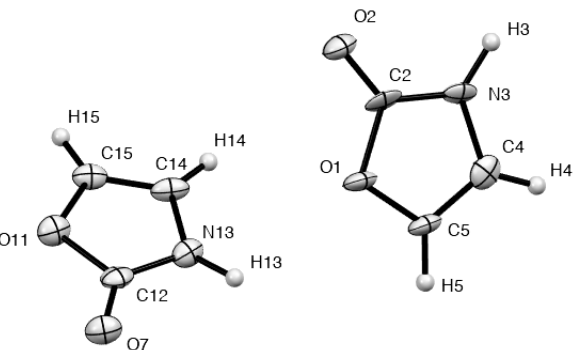
Figure 3. Structure and numbering of the two independent molecules of compound 4.